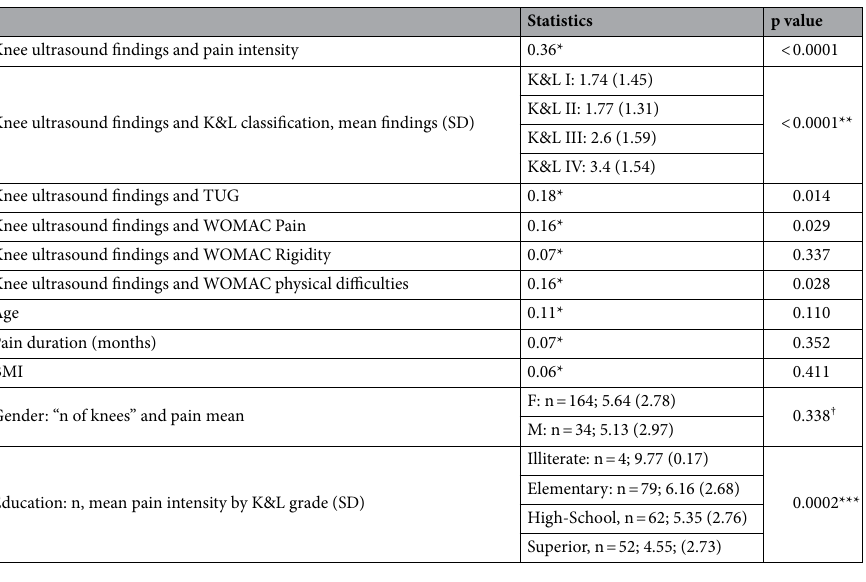
Table 3. Results. n number, SD standard deviation, BMI body mass index, F female, M male, K&L Kellgren and Lawrence, WOMAC Western Ontario and McMaster Universities Osteoarthritis Index, TUG timed up and go test. *Pearson Correlation (r). **ANOVA of number of USG findings for K&L I and K&L III, p = 0.041, K&L I and K&L IV, p < 0.001, K&L II and K&L IV, p < 0.001 (with Bonferroni correction); [AS5]. ***ANOVA education illiterate and superior, p = 0.002, illiterate and high school, p = 0.01; and fundamental and superior, p = 0.006 (with Bonferroni correction). † Unpaired student